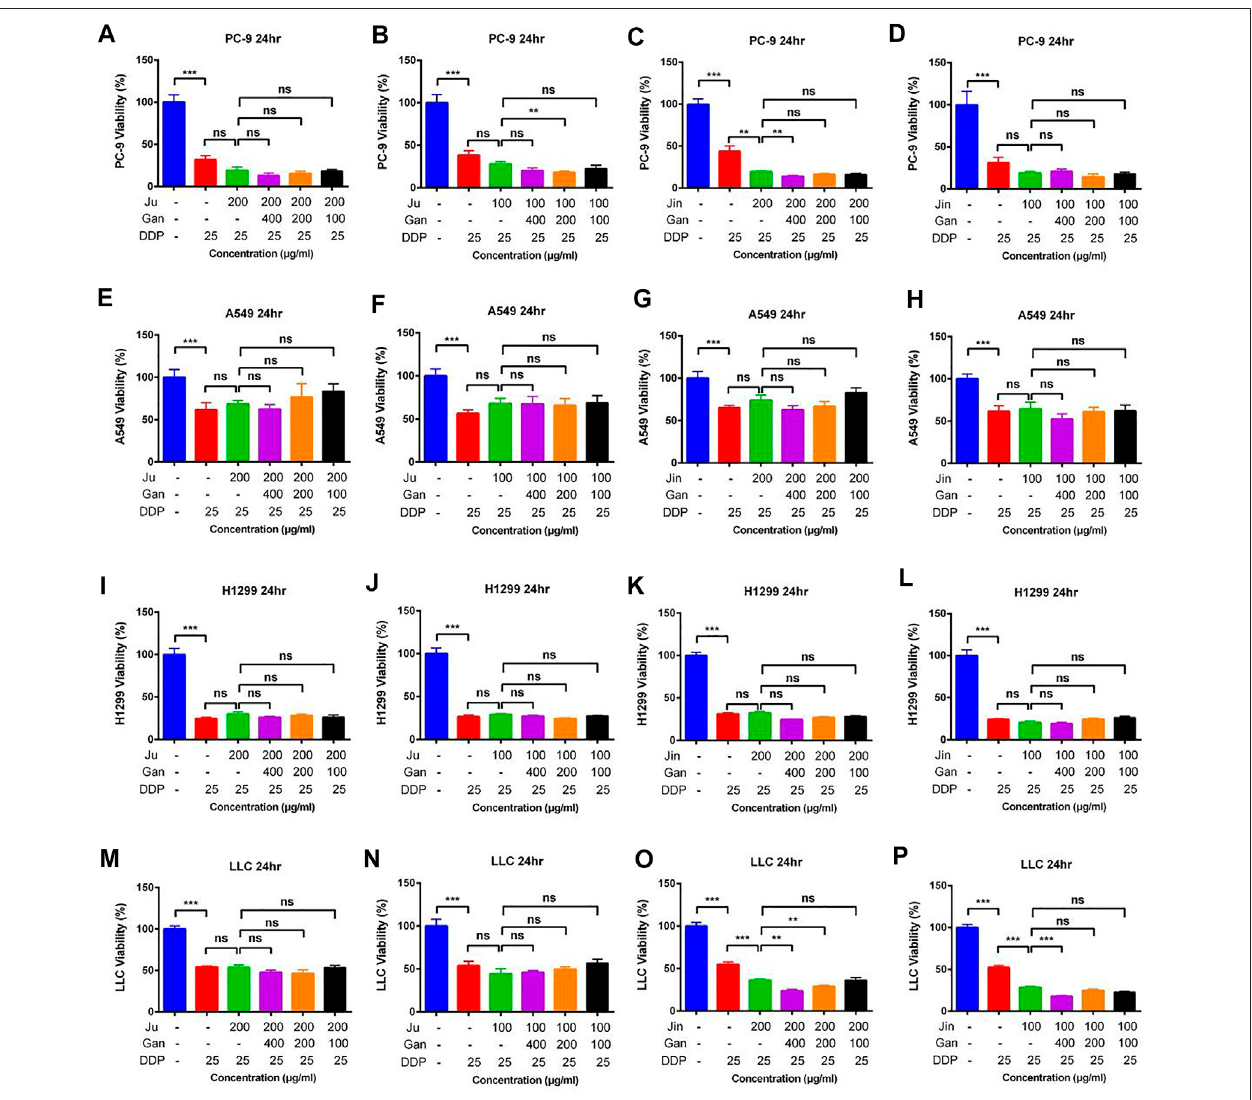
FIGURE 3 | The effect of two Chinese medicine formulas on the antitumor activity of DDP in vitro (A – C) Dose of Ju + Gan or Jin + Gan on the antitumor activity of DDPinPC-9cells. (D – F) DoseofJu+GanorJin+GanontheantitumoractivityofDDPinA549cells.(G – I)DoseofJu+GanorJin+GanontheantitumoractivityofDDP inH1299cells. (J – L) DoseofJu+GanorJin+GanontheantitumoractivityofDDPinLLCcells.Errorbarsarerepresentedasmean±SEM. p valuesweredetermined by Student ’ s t test (* p < .05, ** p < .01, *** p < .001).